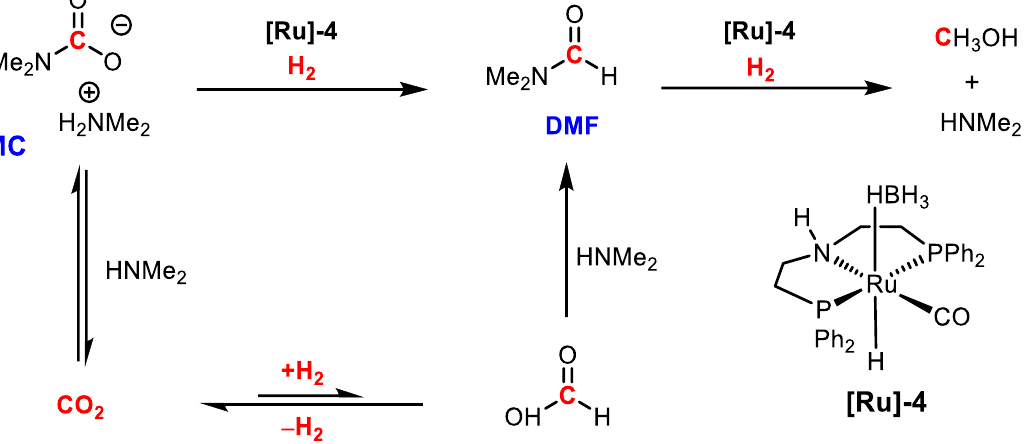
Figure 4. Amine assisted Ru-catalyzed hydrogenation of CO 2 .